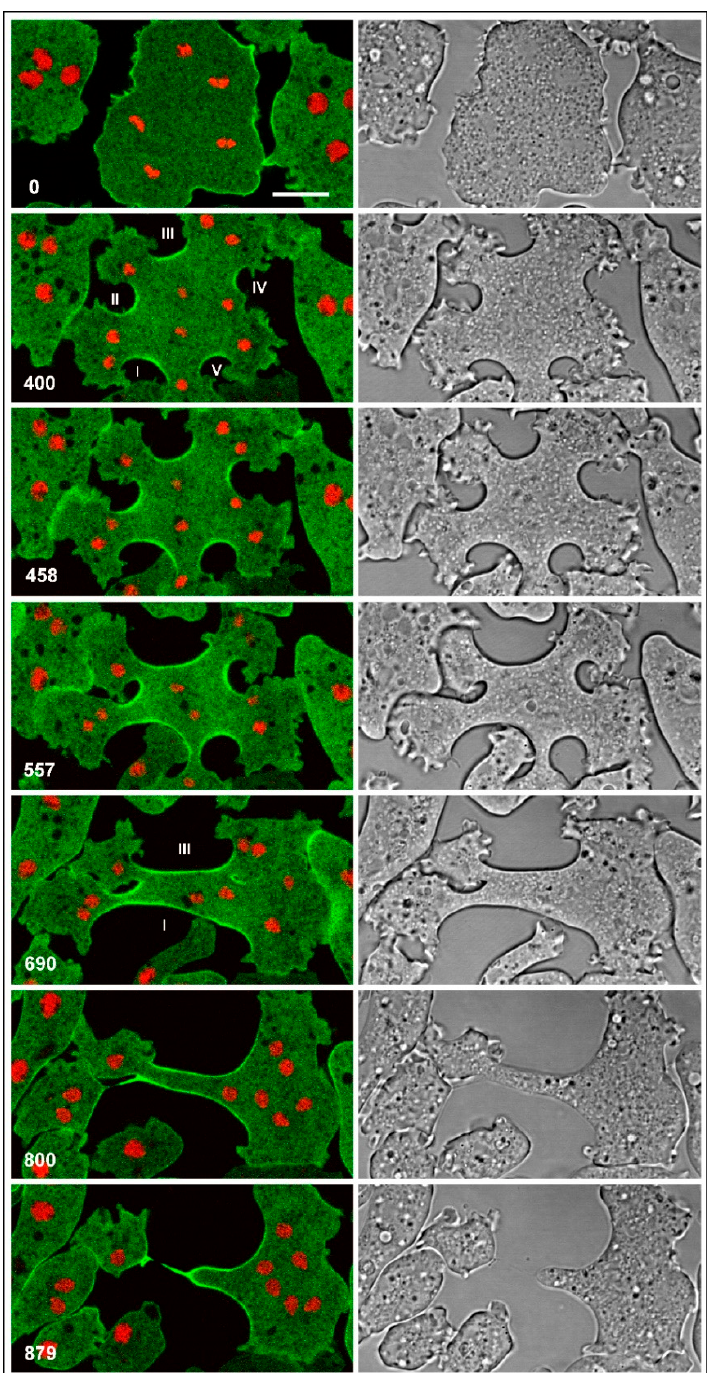
Figure 5. Synchronous mitosis and division of a multinucleate myosin-II-null cell. Like the cells in Figure 2, this cell expressed GFP-cortexillin I (green) and mRFP-histone 2B (red). Initially, five unilateral furrows formed that were enriched in cortexillin (400 s to 557 s frames). Later on, two long furrows prevailed (690 s and 800 s frames), and a final abscission occurred between them (879 s frame). The cell was flattened by agarose overlay. Time is indicated in seconds after the first frame. Scale bar, 10 µm. The entire sequence is shown in supplementary Video S5.